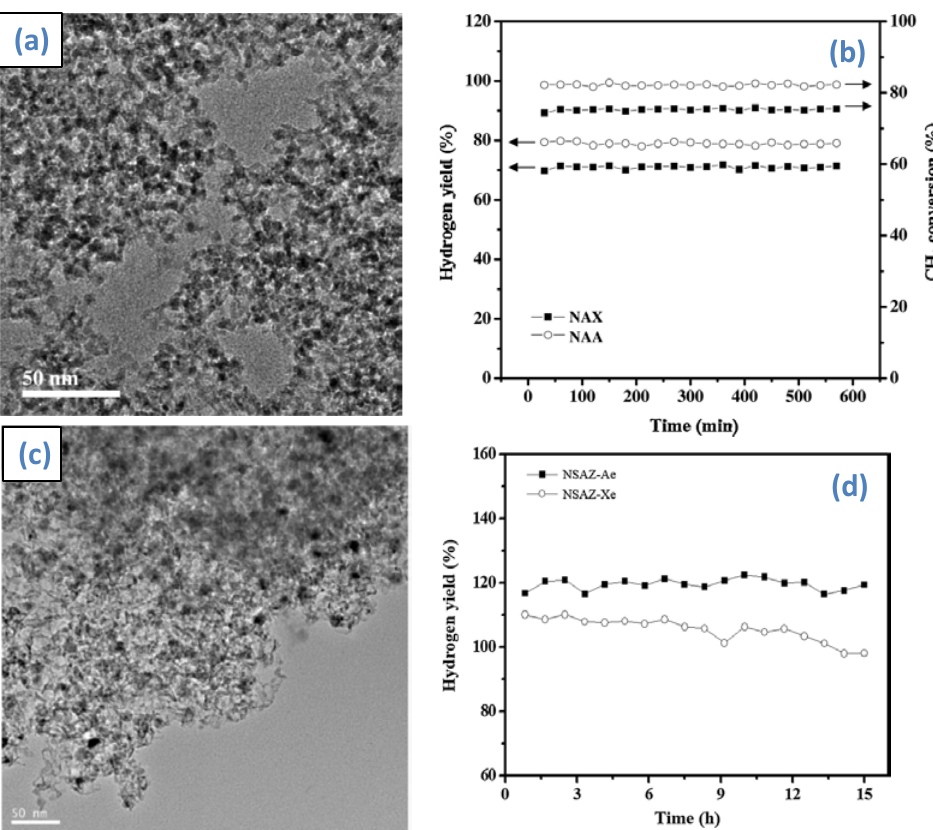
Figure 15. ( a ) TEM image of Ni-Al 2 O 3 aerogel (NAA) catalyst reduced at 700 °C for 3 h; ( b ) Hydrogen yield and CH 4 conversion with time on stream in the tri-reforming of methane over xerogel Ni-Al 2 O 3 (NAX) and NAA catalysts at 700 °C. All the catalysts were reduced at 700 °C for 3 h prior to the reaction. (Adapted with permission from [103]. Copyright Elsevier, 2015); ( c ) TEM image of Ni-Sr-Al 2 O 3 -ZrO 2 aerogel (NSAZ-Ae) catalyst reduced at 700 °C for 2 h. ( d ) Hydrogen yield with time on stream in the steam reforming of ethanol over NSAZ-Ae and Ni-Sr-Al 2 O 3 -ZrO 2 -xerogel (NSAZ-Xe) catalysts at 450 °C. All the catalysts were reduced at 700 °C for 2 h prior to the reaction. (Adapted with permission from [105]. Copyright Elsevier, 2016).